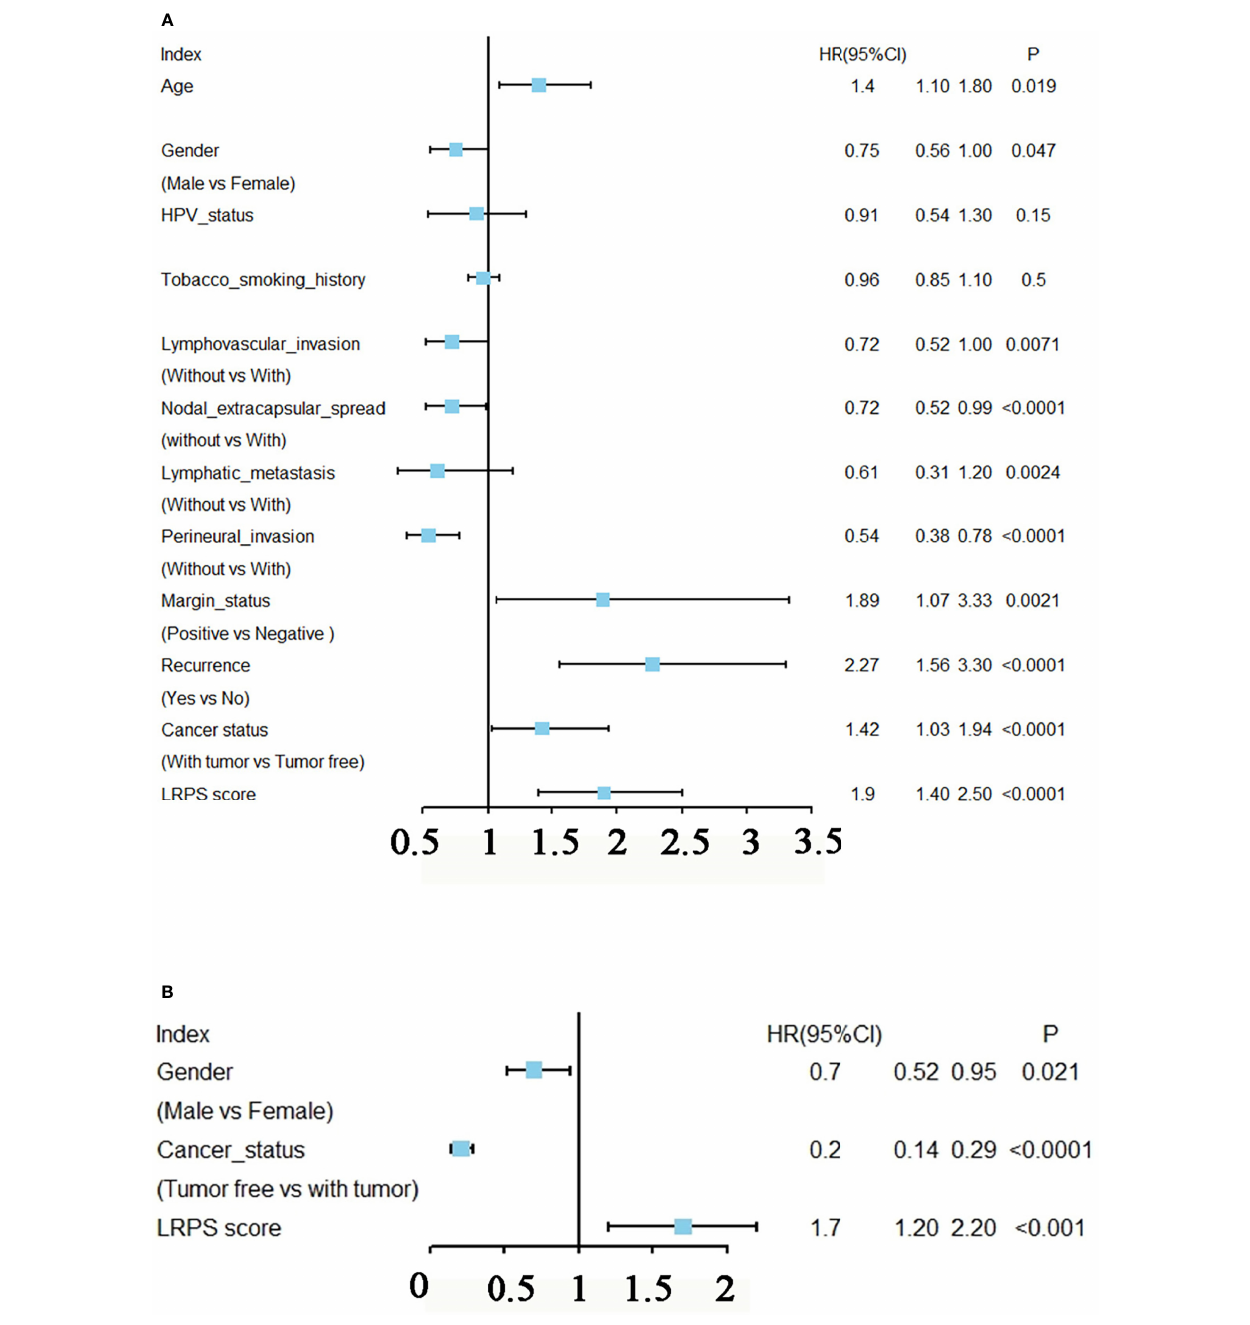
FIGURE 5 | Prognostic analysis of LRPS in HNSCC. (A) Univariate Cox analysis of clinicopathologic factors and the LPRS score in TCGA-HNSCC patients. (B) Multivariate Cox analysis of the signi fi cant factors according to results from the univariate Cox analysis ( p <